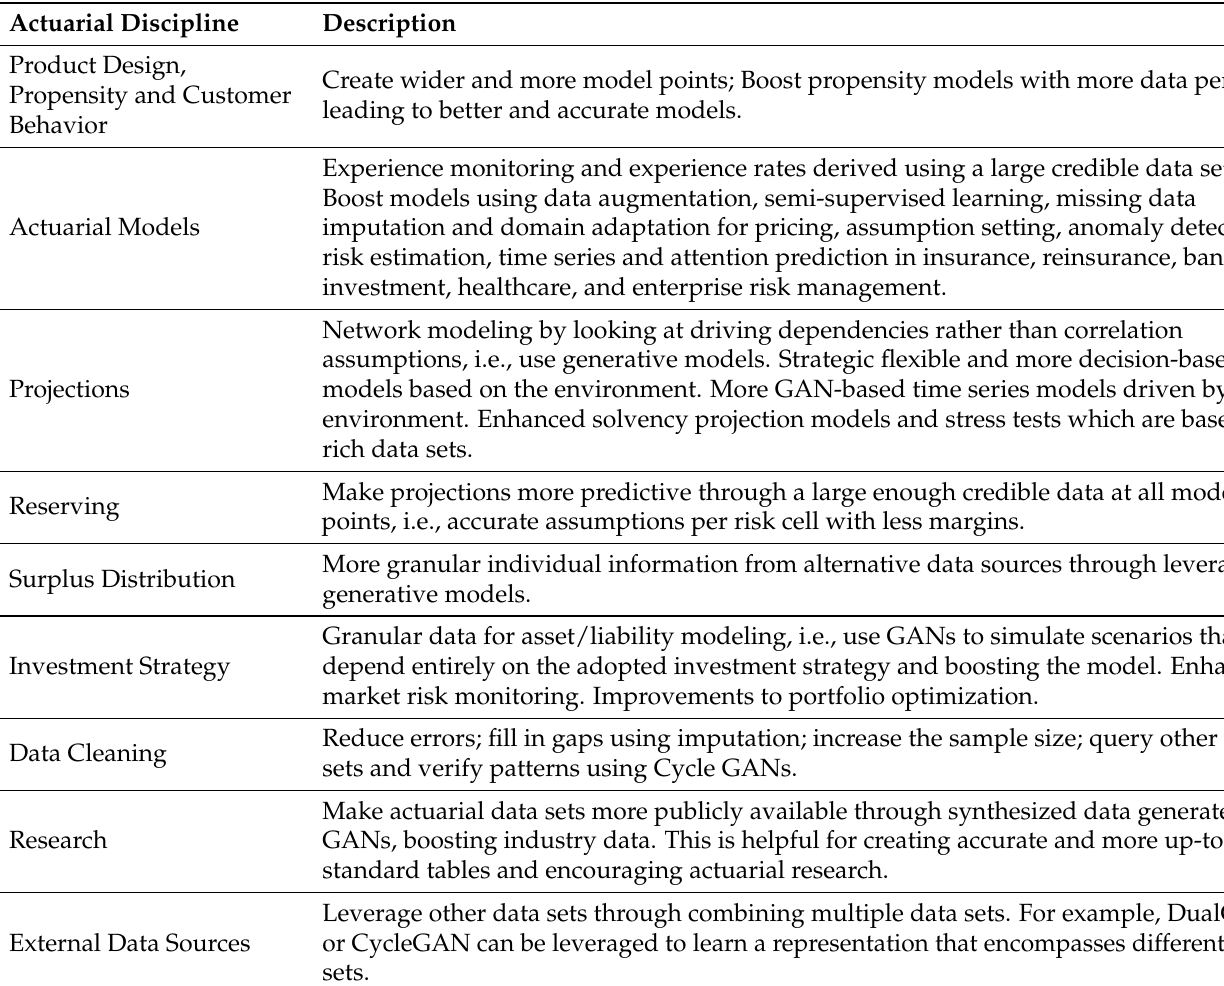
Table 2. Potential GAN applications in actuarial